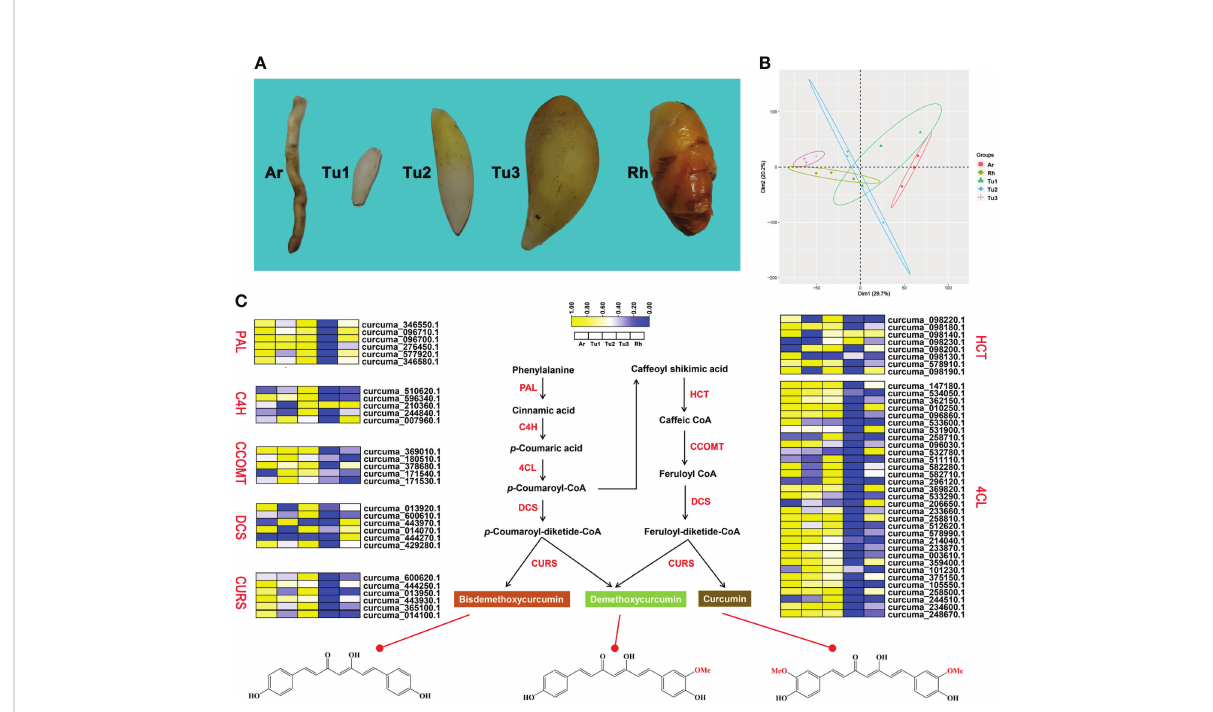
FIGURE 5 Curcumin biosynthesis pathway in turmeric. (A) Phenotypic comparison of fi ve root developmental stages of turmeric. (B) Principal component analysis (PCA) of fi ve turmeric tissues based on the transcriptomic data. Three biological replicates were performed for each developmental stage. (C) Relative expression pro fi les (yellow-blue scale) of genes encoding enzymes possibly involved in curcumin biosynthesis (heat map). The enzymes involved at each step are shown in